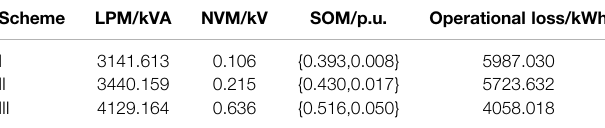
TABLE 2 | Improvement of SOM based on controllable devices.